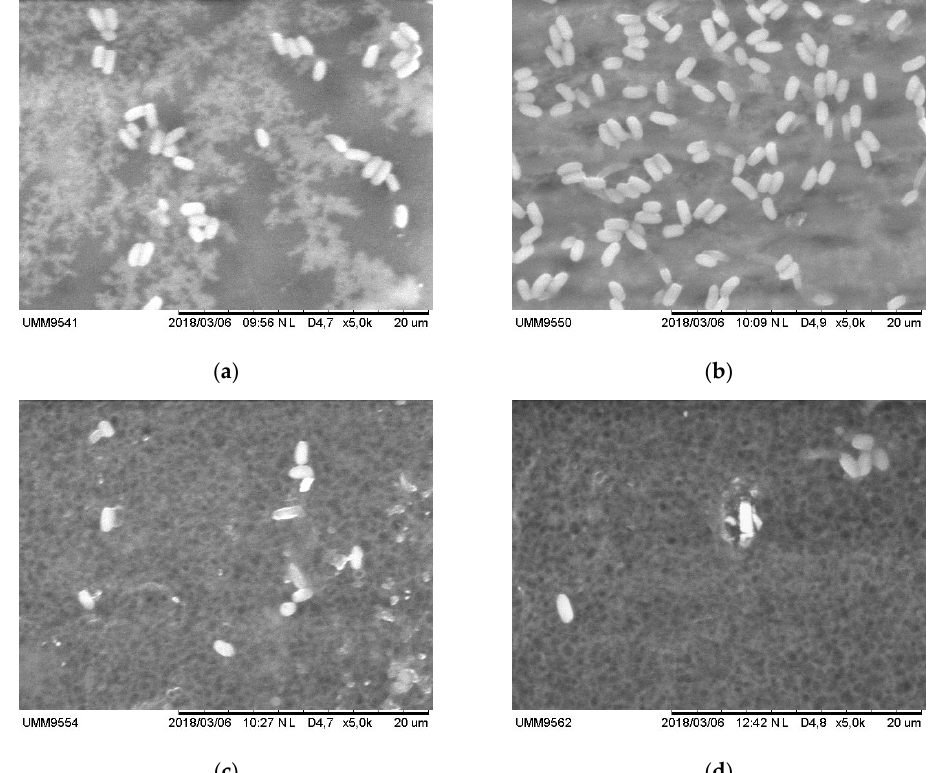
Figure 9. Membranes surface image using SEM after bacterial test. ( a ) Pristine membrane (made of DMF solvent), ( b ) Pristine membrane (made of DMAc solvent), ( c ) MMM with 1 wt% Moringa (made of DMF solvent), and ( d ) MMM with 1 wt% Moringa (made DMAc solvent). All SEM images used 5000× magnification.